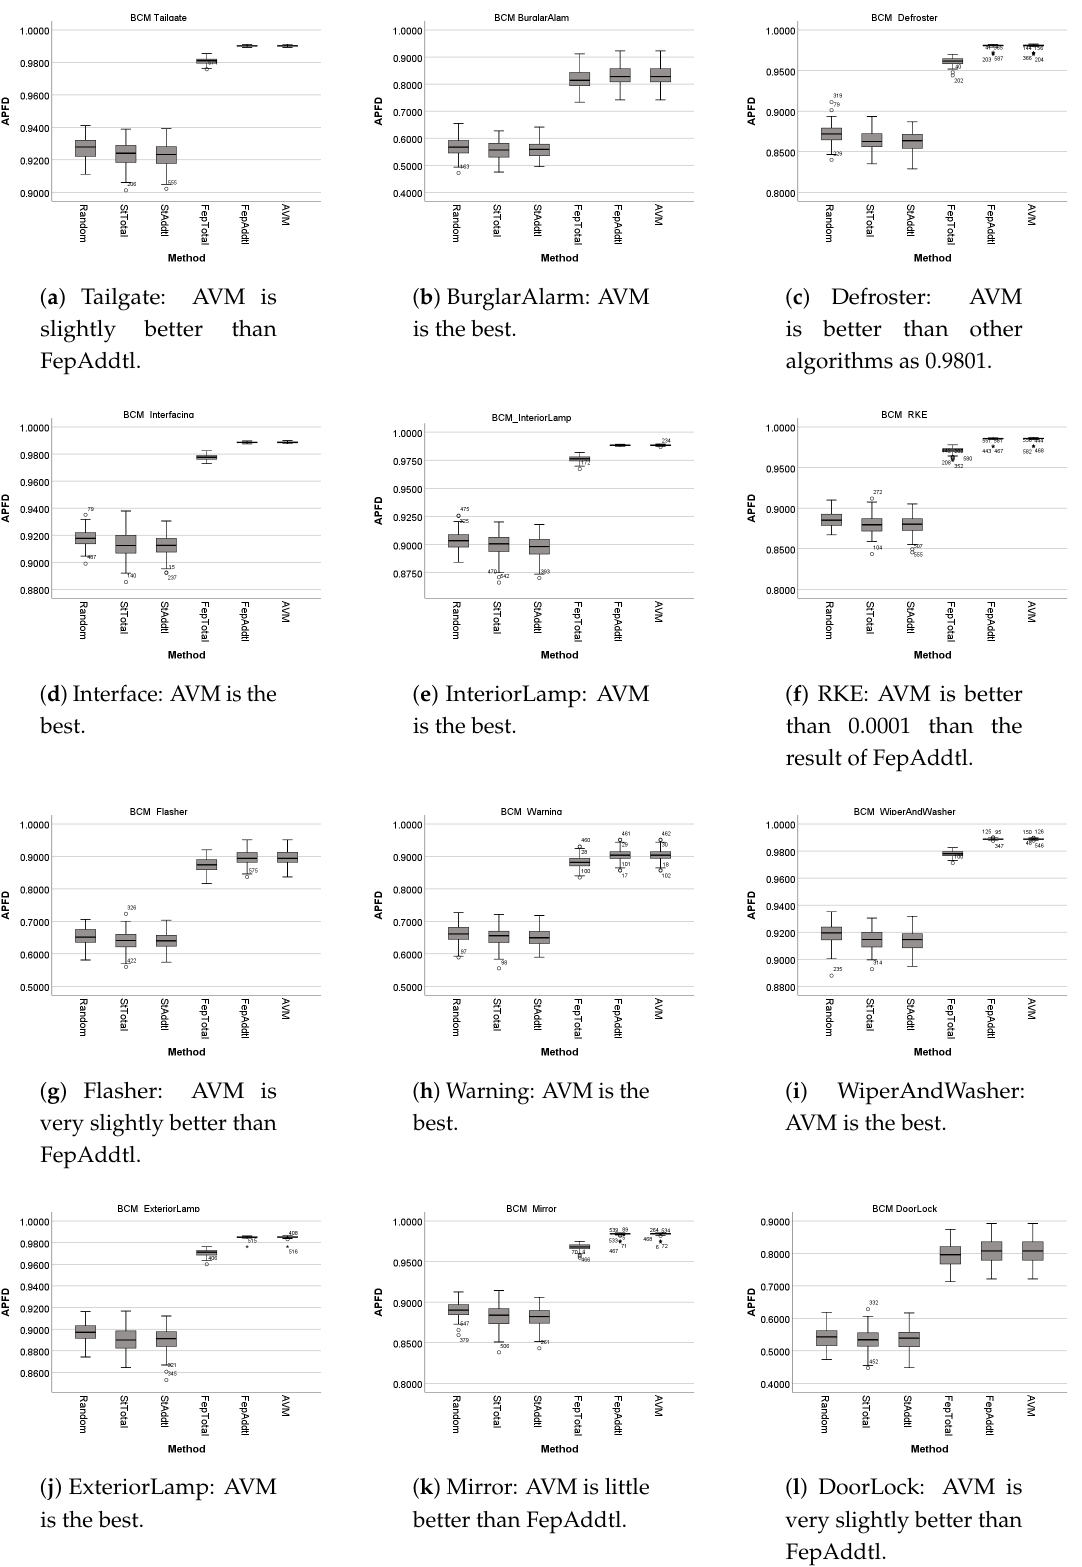
Figure 5. APFD results of the test case prioritization